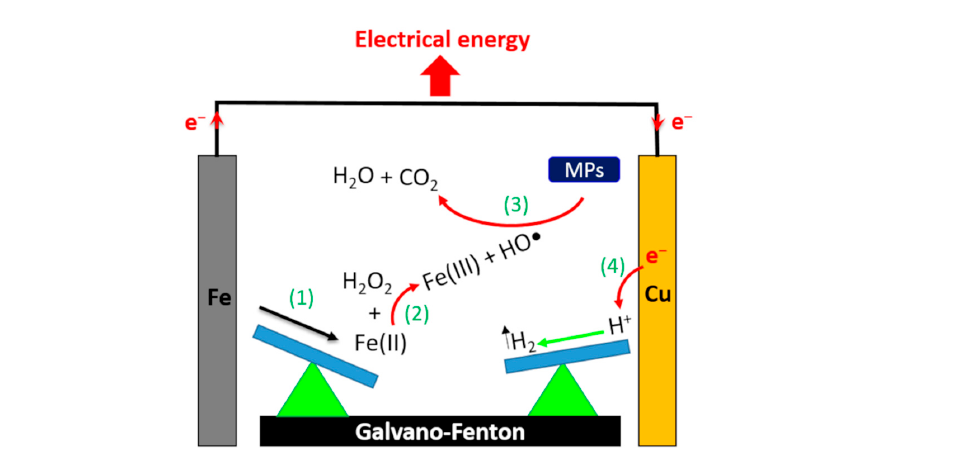
Figure 1. Schematic representation of the mechanism for producing electrical energy with the Galvano–Fenton process.